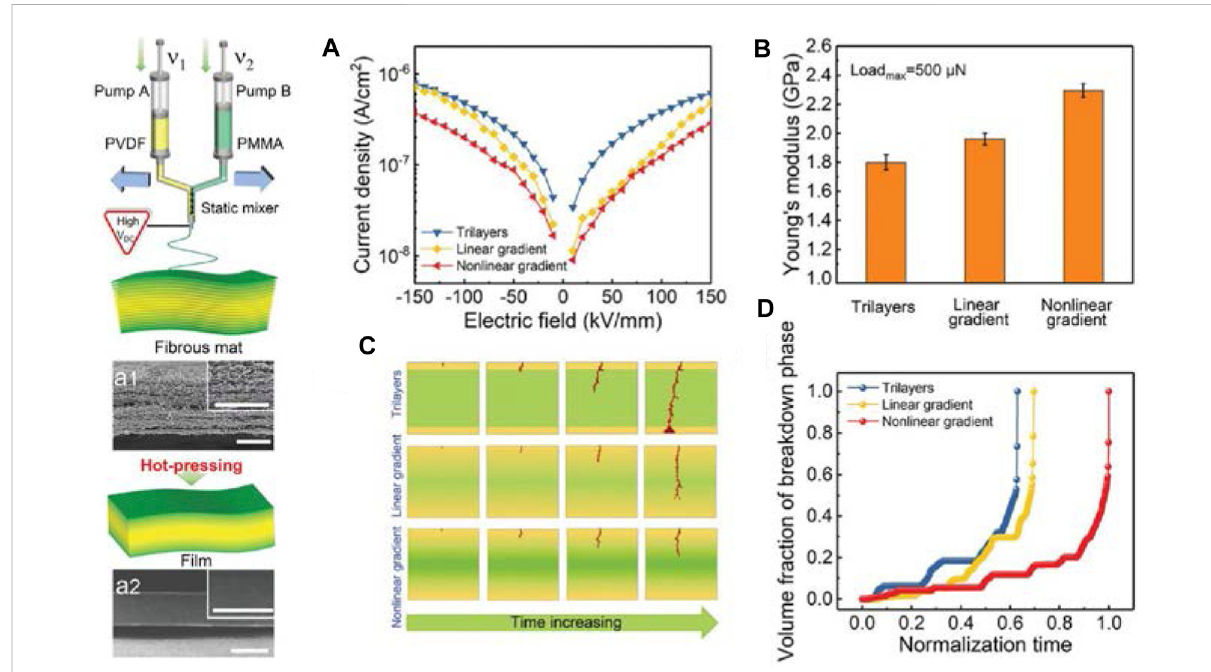
FIGURE 14 Schematicillustration of preparing all-organic PVDF/PMMA binary polymer fi lm, and (A) The leakage current densities; (B) Young ’ s modulus for trilayer, linear gradient, and nonlinear gradient polymer fi lms; (C) Simulated evolution of breakdown paths and (D) volume fraction of breakdown phase for trilayer, linear gradient, and nonlinear gradient polymer fi lms. Reproduced with permission from Ref. 115. Copyright 2022